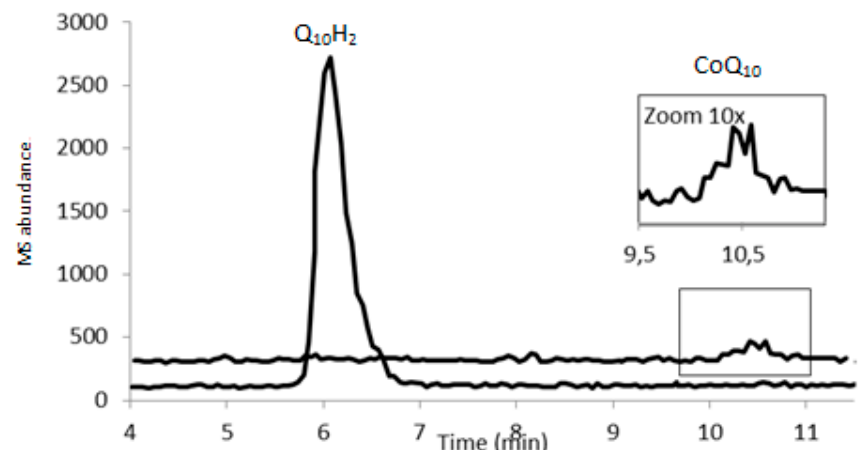
Figure 4. Chromatogram from the MRM trace of a canine plasma sample using the LC-MS/MS method. Lower trace: CoQ 10 H 2 . Upper trace: CoQ 10 . The insert shows 10 times zoom of the CoQ 10 peak.